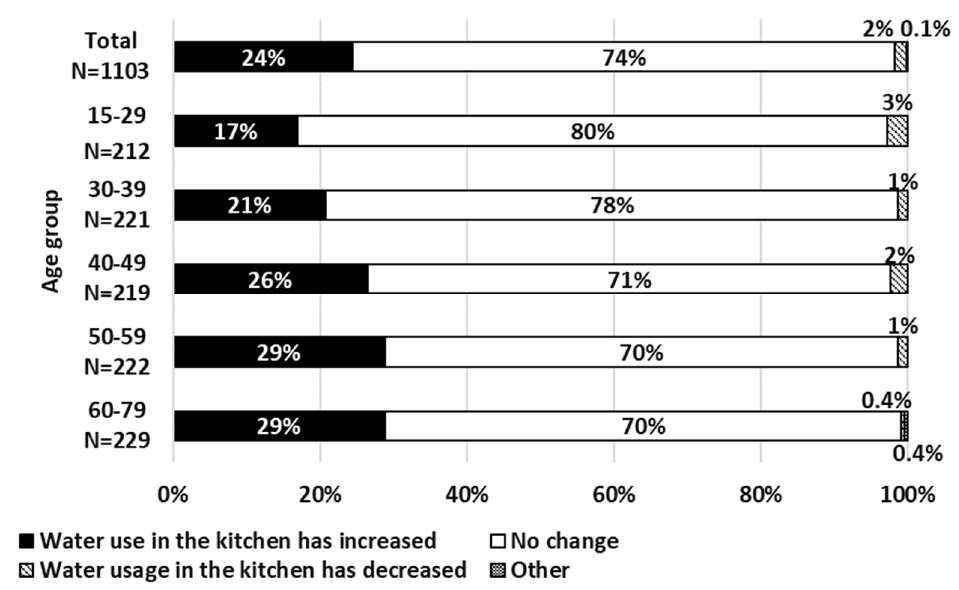
Figure 11. Changes in water usage in the kitchen.